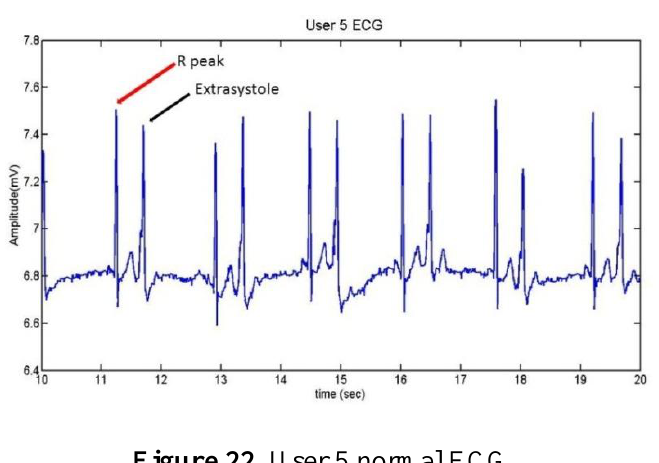
Figure 22. User 5 normal